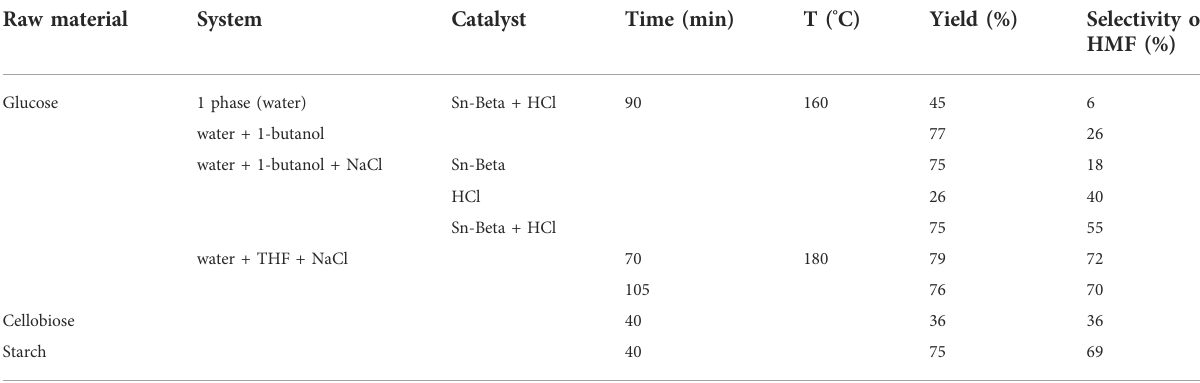
TABLE 2 Result of the conversion of glucose, cellobiose and starch into HMF (adapted from Nikolla et al., 2011). Raw